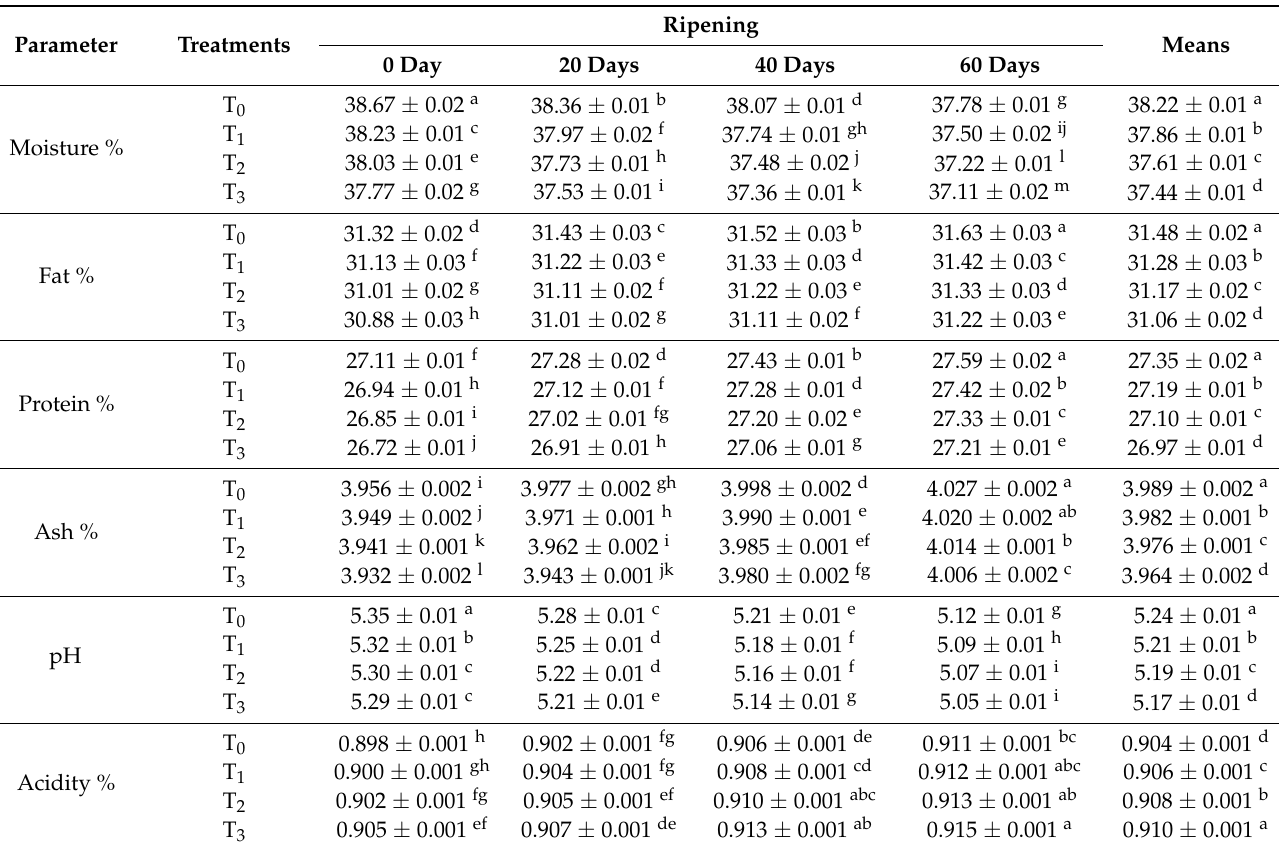
Table 1. Composition of all cheese treatments during the ripening period (means ± standard deviation,